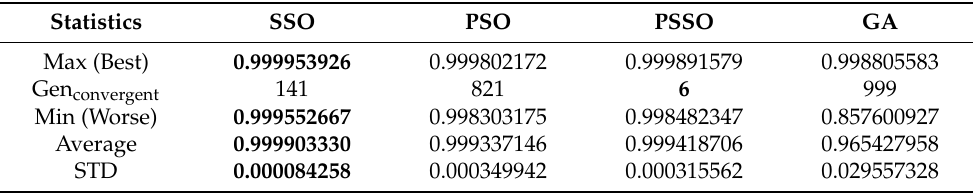
Table 10. The statistics of system reliability for benchmark 4.